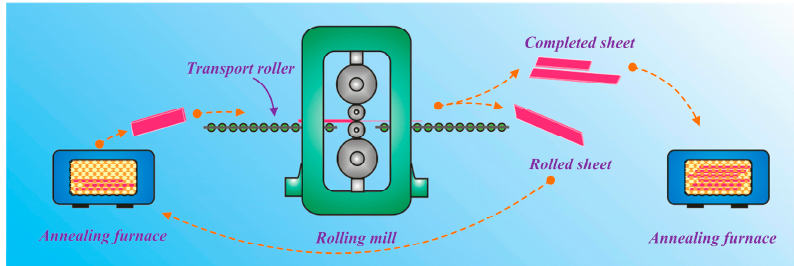
Figure 1. Rolling process diagram of the Mg-Li alloy sheet.